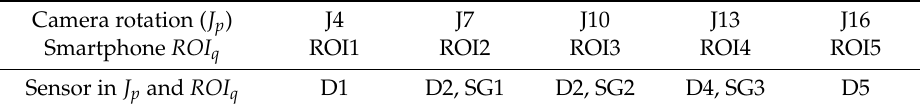
Table 1. Contact sensors in RCS rotations and smartphone ROIs.